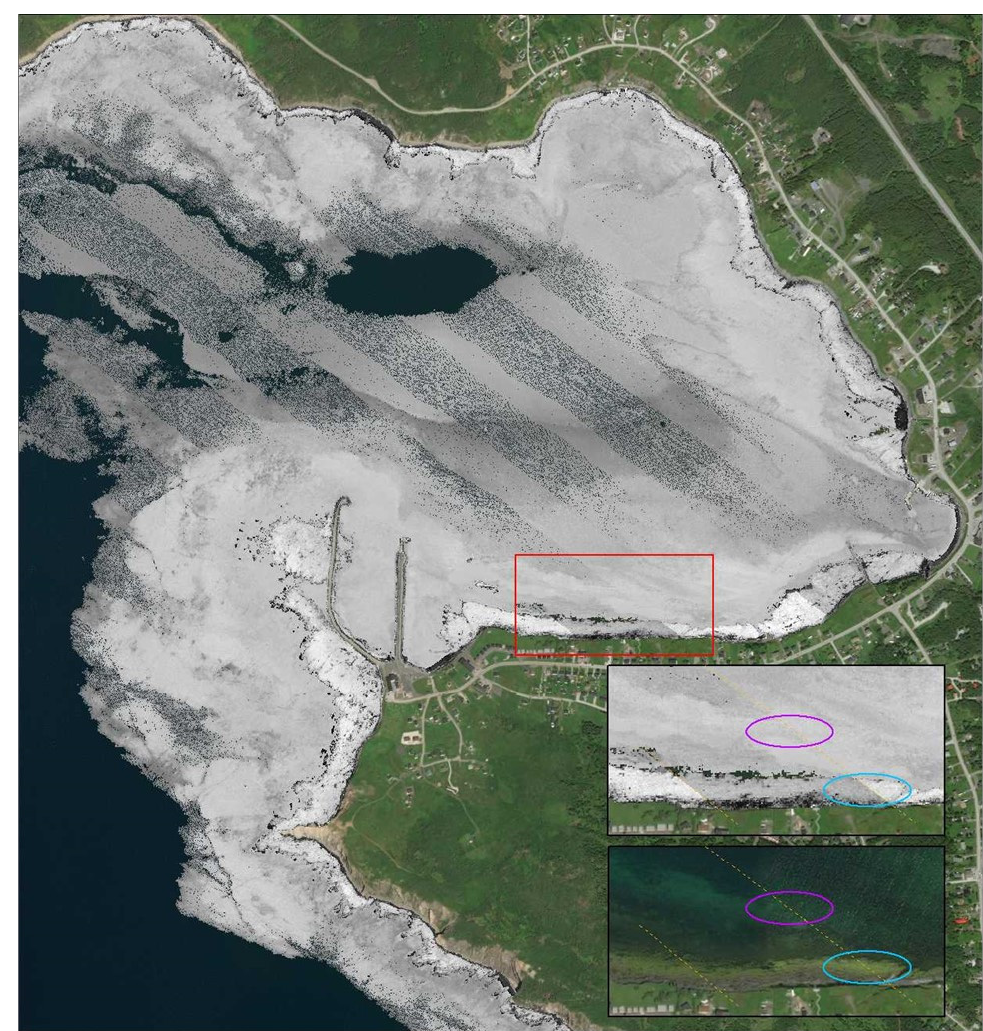
Figure 6. Flightline artifacts (striping) can be seen throughout the 2 m intensity data. The insets (red box) show the differing intensities between flight lines for homogeneous ground features such as rockweed (blue ellipse) and sediment (purple ellipse).